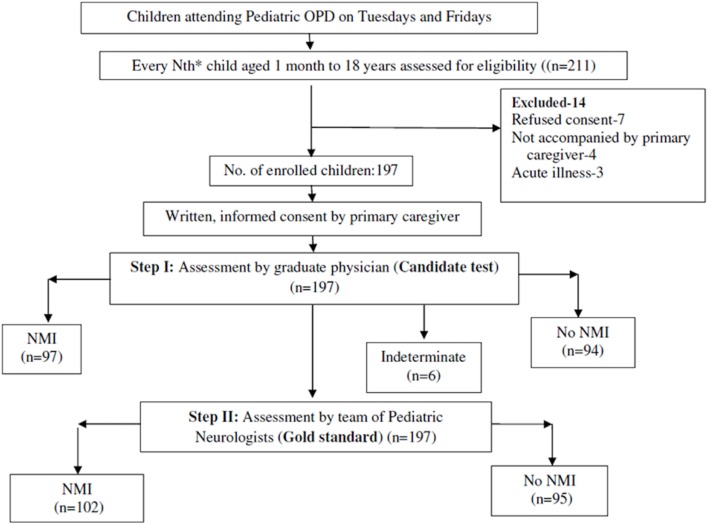
Flow of the study.